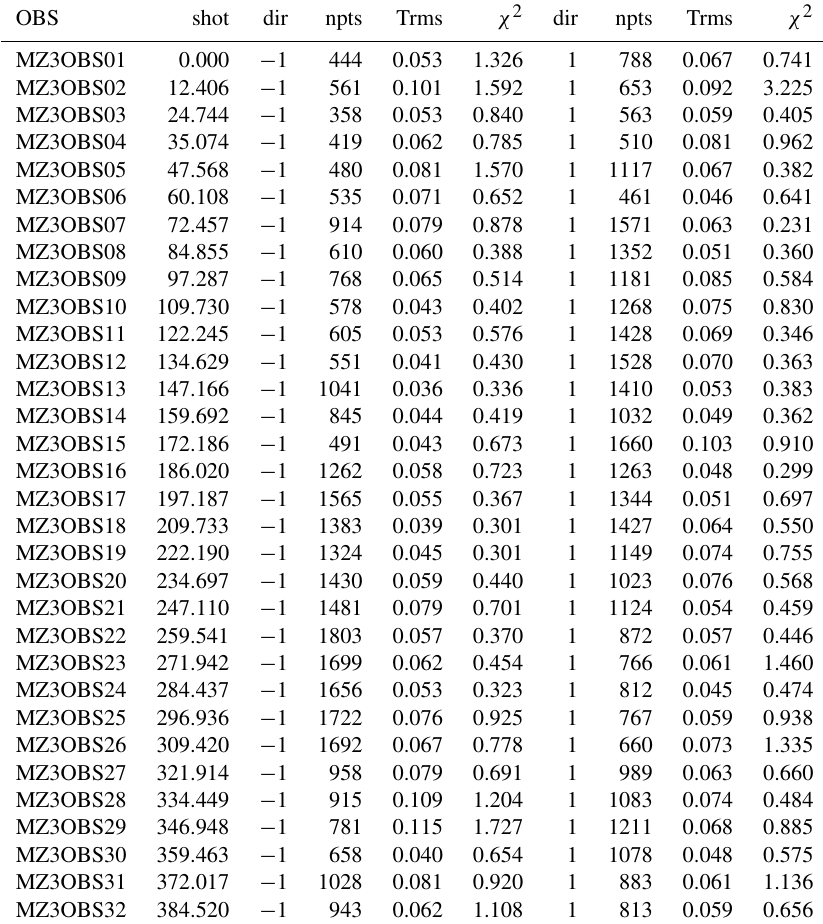
Table A2. OBS names and distance along the MZ3 model, phase propagation direction, number of explained events (npts), residual mean square (Trms, in seconds), and normalized chi-squared